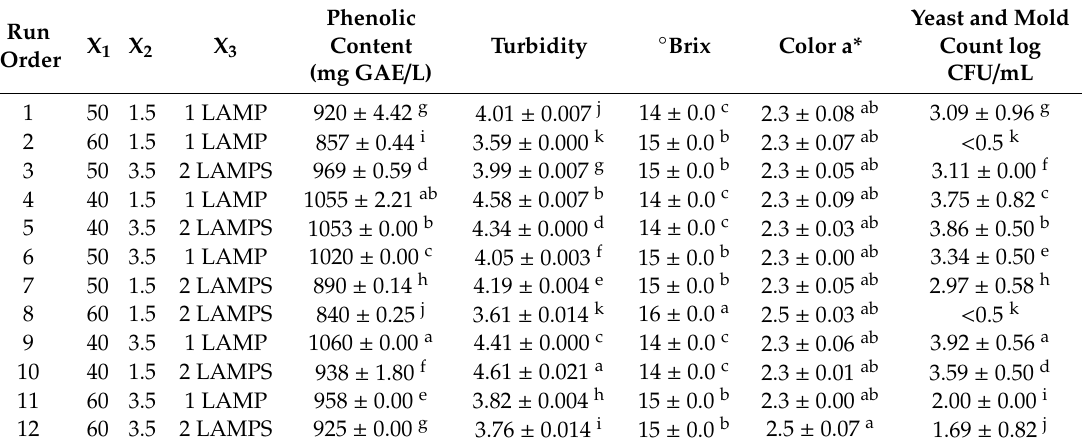
Table 2. Experimental parameters in the UV process and the observed response values for pomegranate juice.